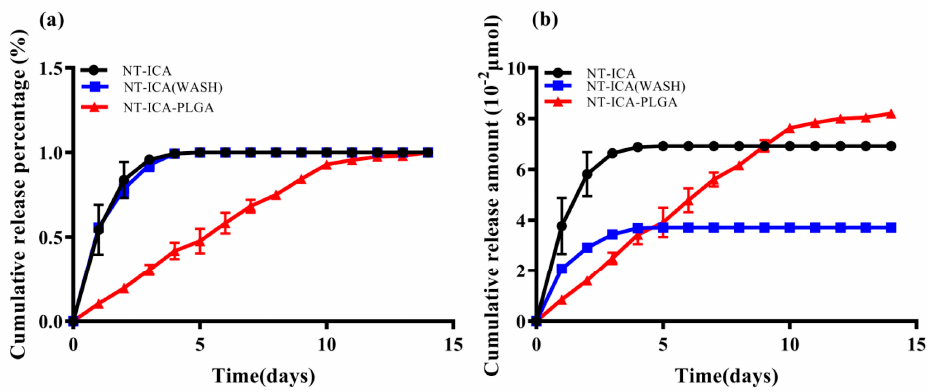
Figure 4. In vitro drug release curve of different surfaces. ( a ) Cumulative release percentage curve; ( b ) Cumulative release amount curve. Abbreviations: NT-ICA, icariin-loaded TiO 2 nanotubes; NT-ICA (WASH), icariin-loaded TiO 2 nanotubes surface, washing out the loosely attached icariin; NT-